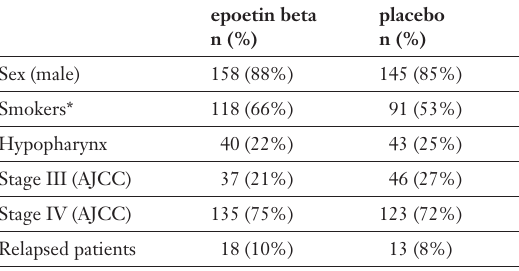
Characteristics of the subgroup of patients with cancer of the hypopharynx in Henke’s study